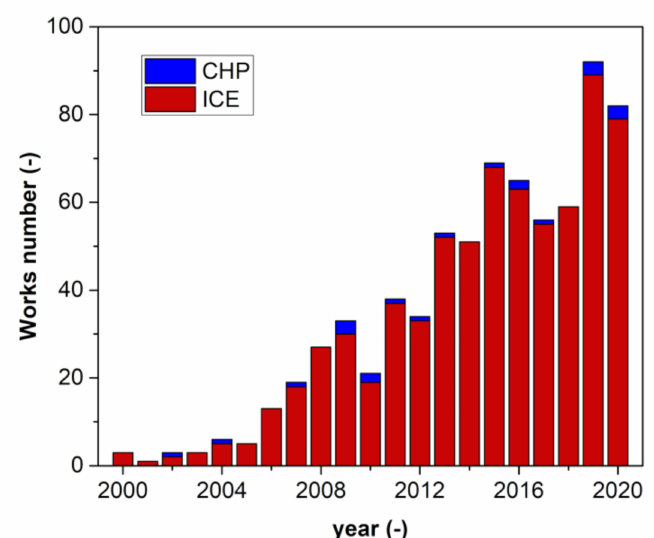
Figure 1. Number of papers on biodiesel-fired internal combustion engines from 2000 to 2020. Automotive and small power applications (red bar), combined heat and power (CHP) generation (blue bar). Authors elaboration on Scopus data [23]. Document search criterion refers to “Article